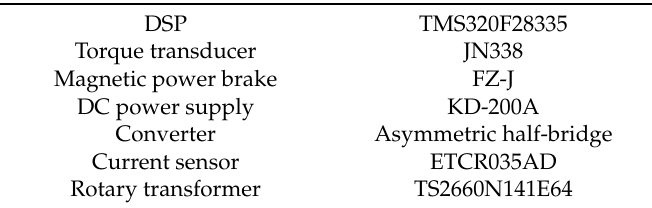
Table 2. Specification of controller.